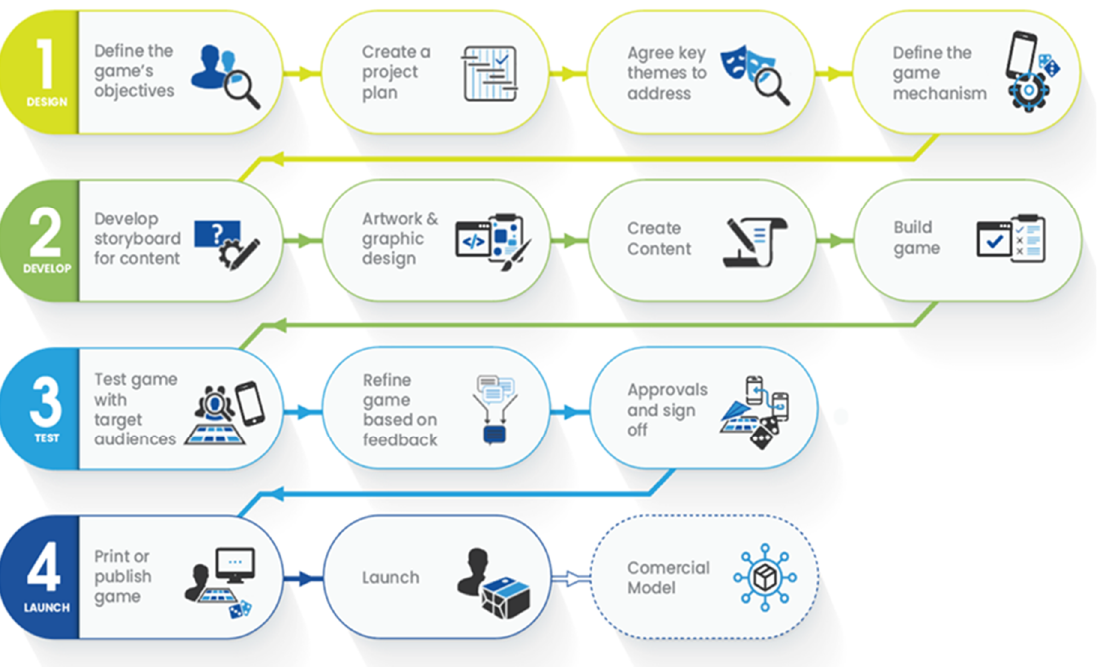
Figure 1. Focus Games Ltd’s Game development process/pathway [16].